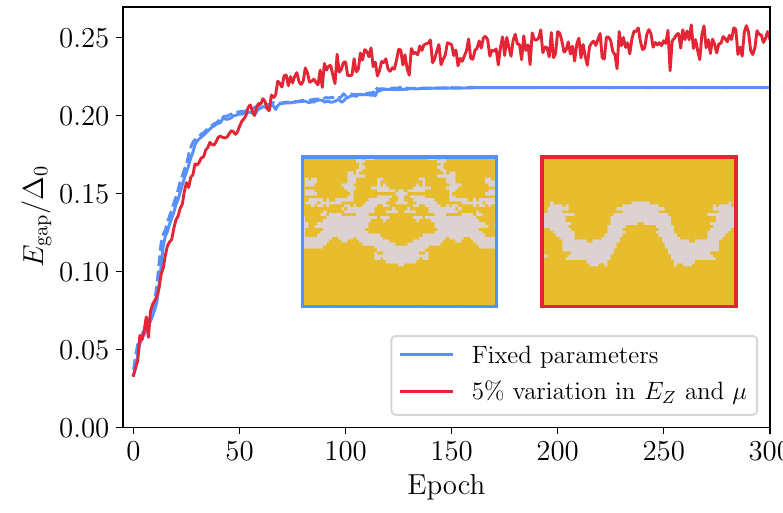
Figure 5: A comparison of the behavior of the optimizer with fixed Hamiltonian pa- rameters and with random fluctuations in the chemical potential and Zeeman field. The blue curve shows the exact topological gap computed at each epoch for the opti- mizer with fixed parameters. At approximately 130 epochs, the optimizer gets stuck in a local maximum. In contrast, the optimization with parameter shifting (red curve) avoids this local maximum and converges to higher gap values. Although the geom- etry has converged, the observed gaps oscillate about their average value due to the parameter shifting. The two inset plots show the converged geometries obtained at each